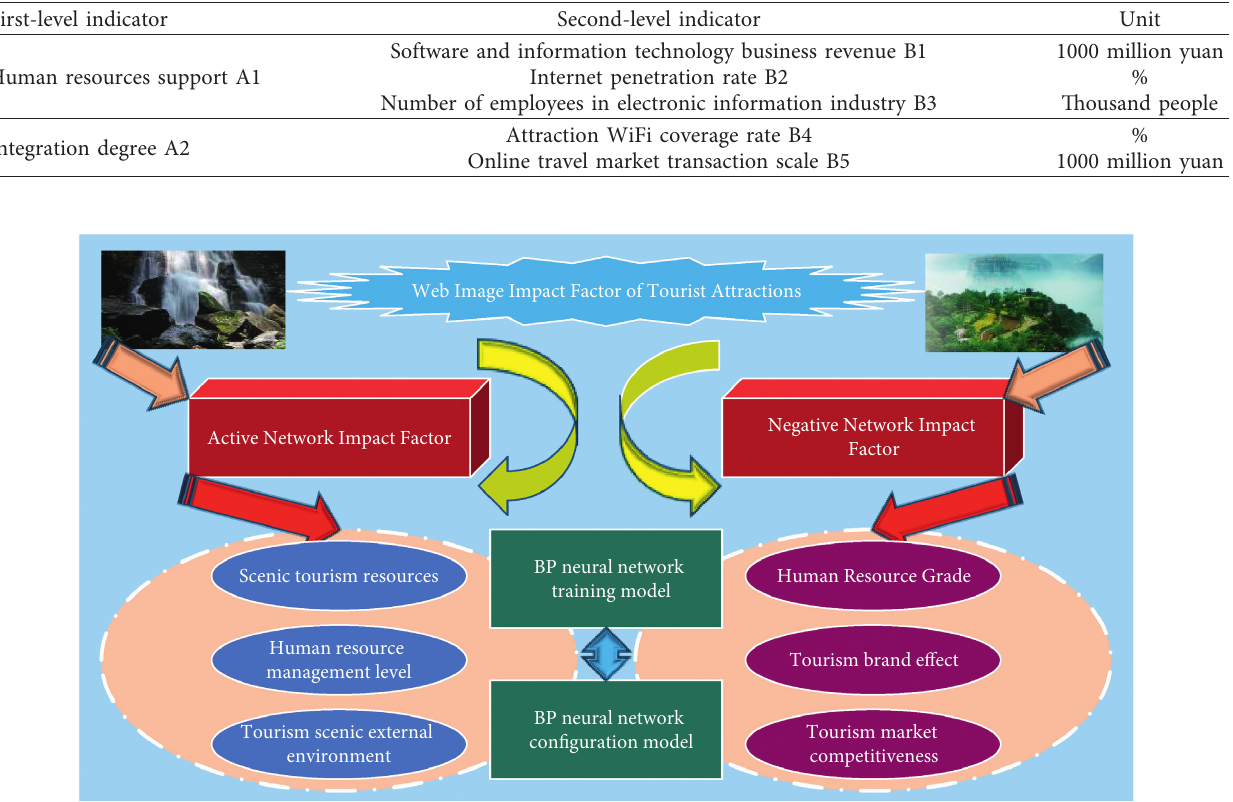
Figure 1: BP neural network model of the impact factor.